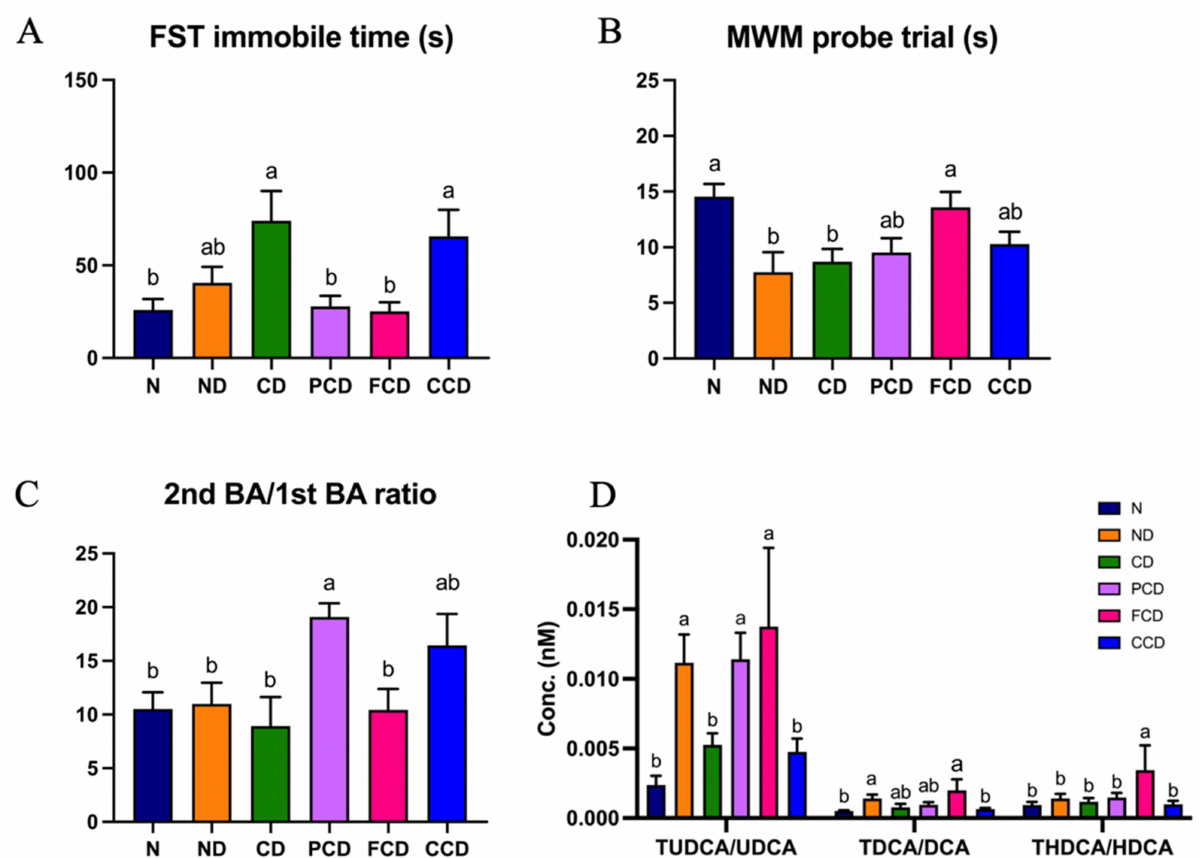
Figure 5. Neurobehavioural outcomes and results of bile acid metabolite analysis. ( A ) Time spent immobile during forced swim test; ( B ) Time spent in platform zone during Morris water maze trial; ( C ) Secondary/primary bile acid ratio in each group; ( D ) Proportions of taurine-conjugated bile acids in faecal samples. Data are expressed as means ± SDs ( n = 6). Values with different superscript letters differ significantly ( p <